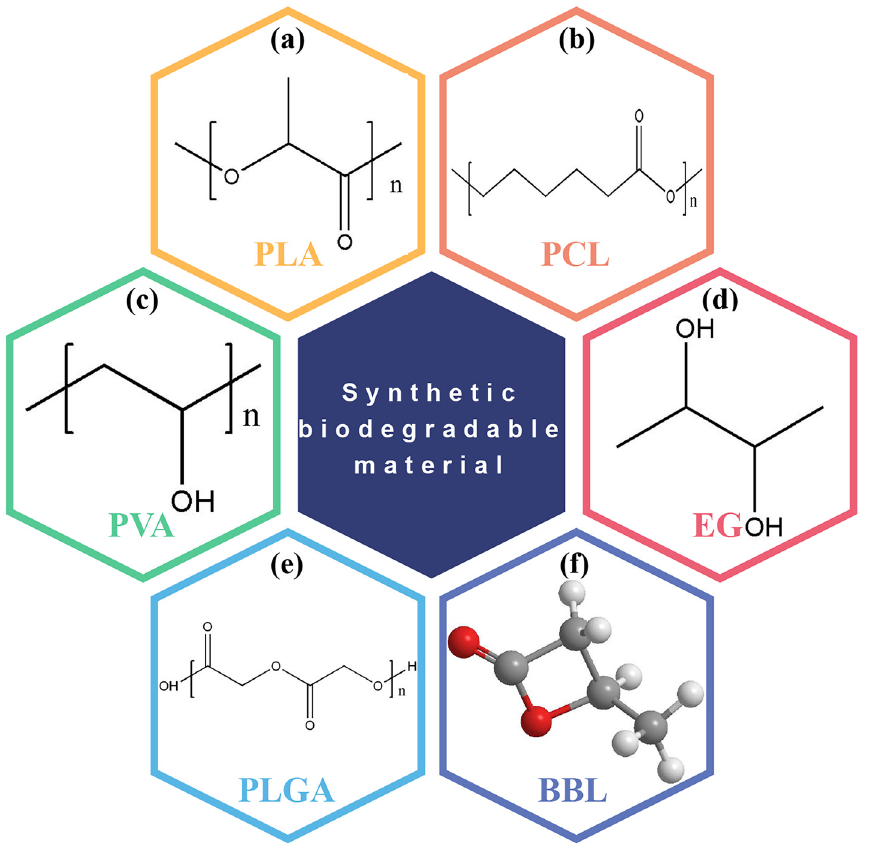
Figure 12. Synthetic degradable material used in TENGs. ( a ) PLA, polylactic acid; ( b ) PCL, poly- caprolactone; ( c ) PVA, polyvinyl alcohol; ( d ) EG, ethylene glycol; ( e ) PLGA, poly(lactic-co-glycolic acid); and ( f ) BBL, β -butyrolactone.